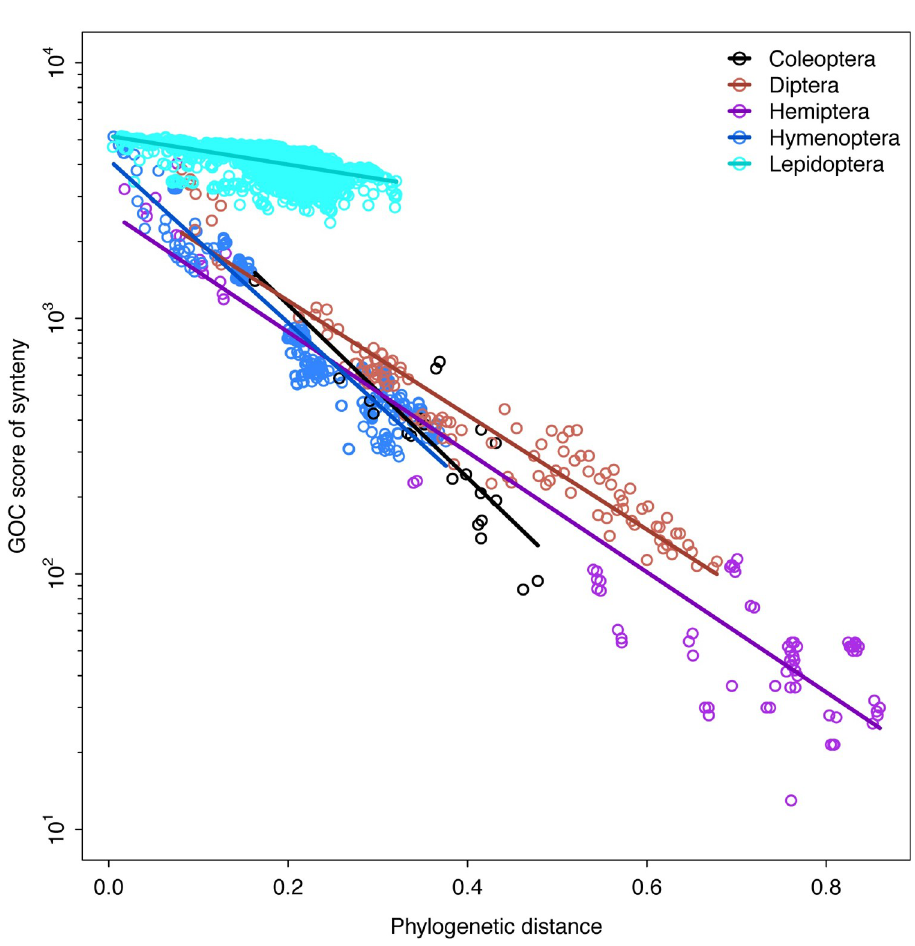
Fig 8. Relationship between synteny and phylogenetic distance across different insect orders. Lines show the best- fitting exponential decay model. Note the log-transformed y-axis. Phylogenetic distance is calculated from a total tree height of 1. Higher values of the GOC score indicate more synteny, lower values less synteny. Synteny decay rate of Lepidoptera differs substantially, however other insect orders also have distinct